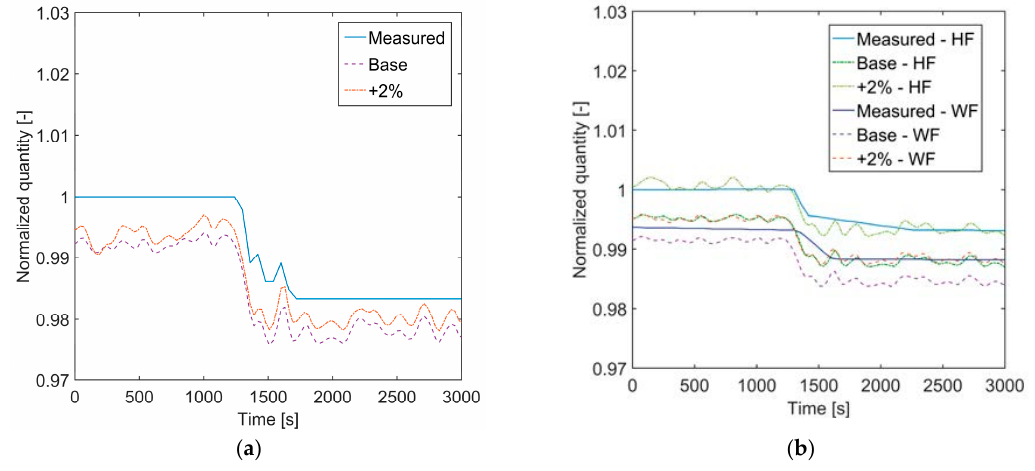
Figure 10. Thermal brine input volume flow rate and temperature: measured time behavior for ( a ) Case 1; and ( b ) Case 2. (“Vflow” = volume flow rate, “Tin” = inlet temperature). Figure 11. Measured and simulated ( a ) pressure; and ( b ) outlet temperatures for Case 1. “Base” refers to the thermal brine inlet volume flow rate as measured, whereas “+2%” to increase of the latter of 2% (HF: Heating fluid, WF: working fluid).